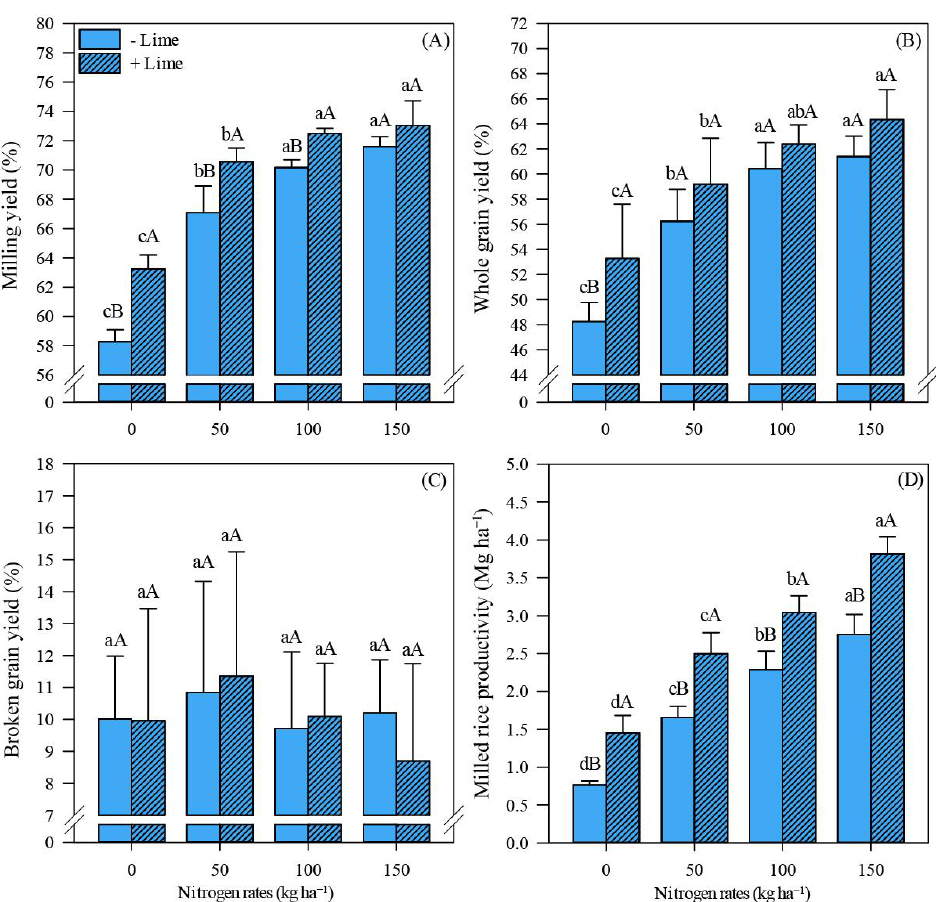
Figure 4. Milling yield ( A ), whole grain yield ( B ), broken grain yield ( C ), and milled productivity ( D ) of upland rice under different treatments (0 (no N applied), 50, 100, and 150 kg N·ha −1 × absence ( − Lime) and presence (+Lime) of lime application). Different lowercase and uppercase letters indi- cate significant differences between N rates and lime applications, respectively, by Student ’ s t -test at p ≤ 0.05. The error bars express the standard error of the mean ( n =